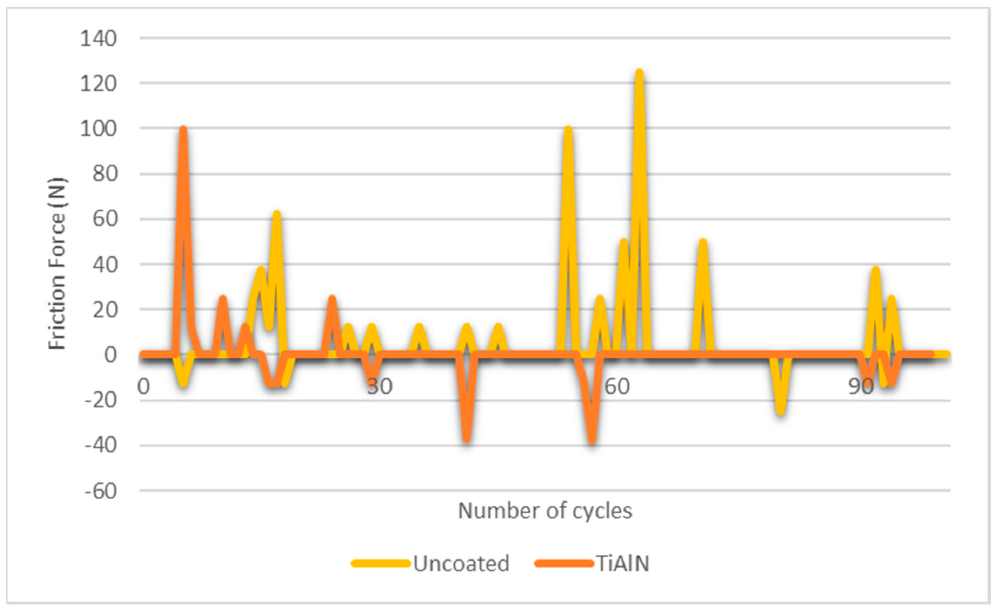
Figure 14. Tangential force evolution over time in block-on-ring tests.